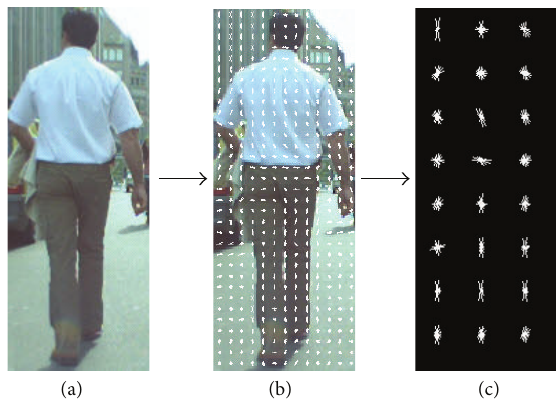
Figure 5: From a candidate input image of size 150 × 382 (a), HOG features are extracted from all locations on the candidate region of an input image with 16 × 16 pixels region (b), and the result is shown in